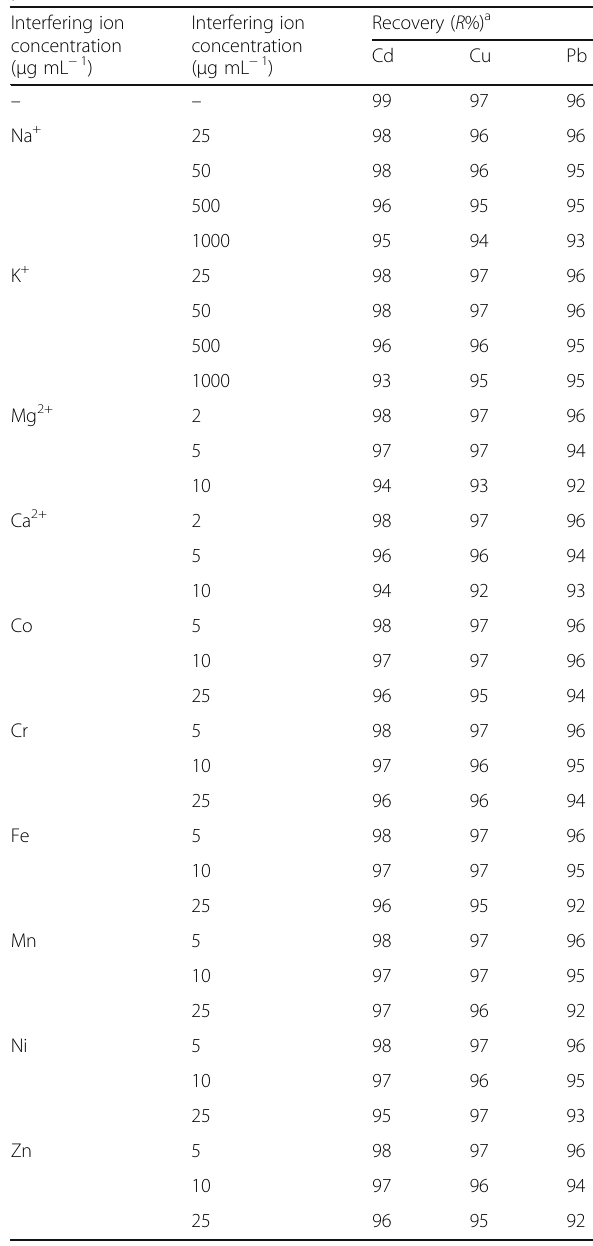
Table 5 Effect of some ions on the recovery of Cd, Cu, and Pb [sample volume, 50 mL; amount of the metal ion, 10 μ